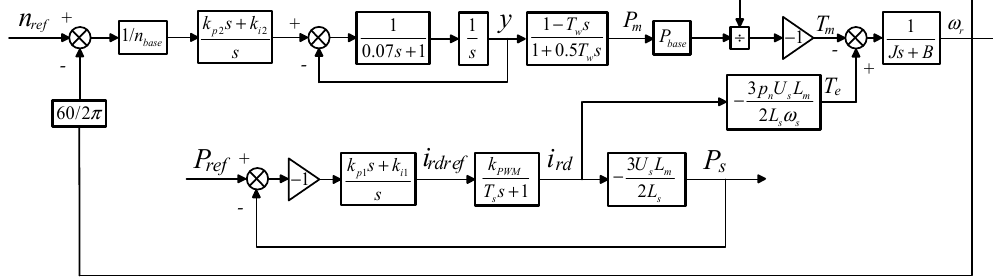
Figure 16. Control block diagram of the power priority control strategy in generating mode.